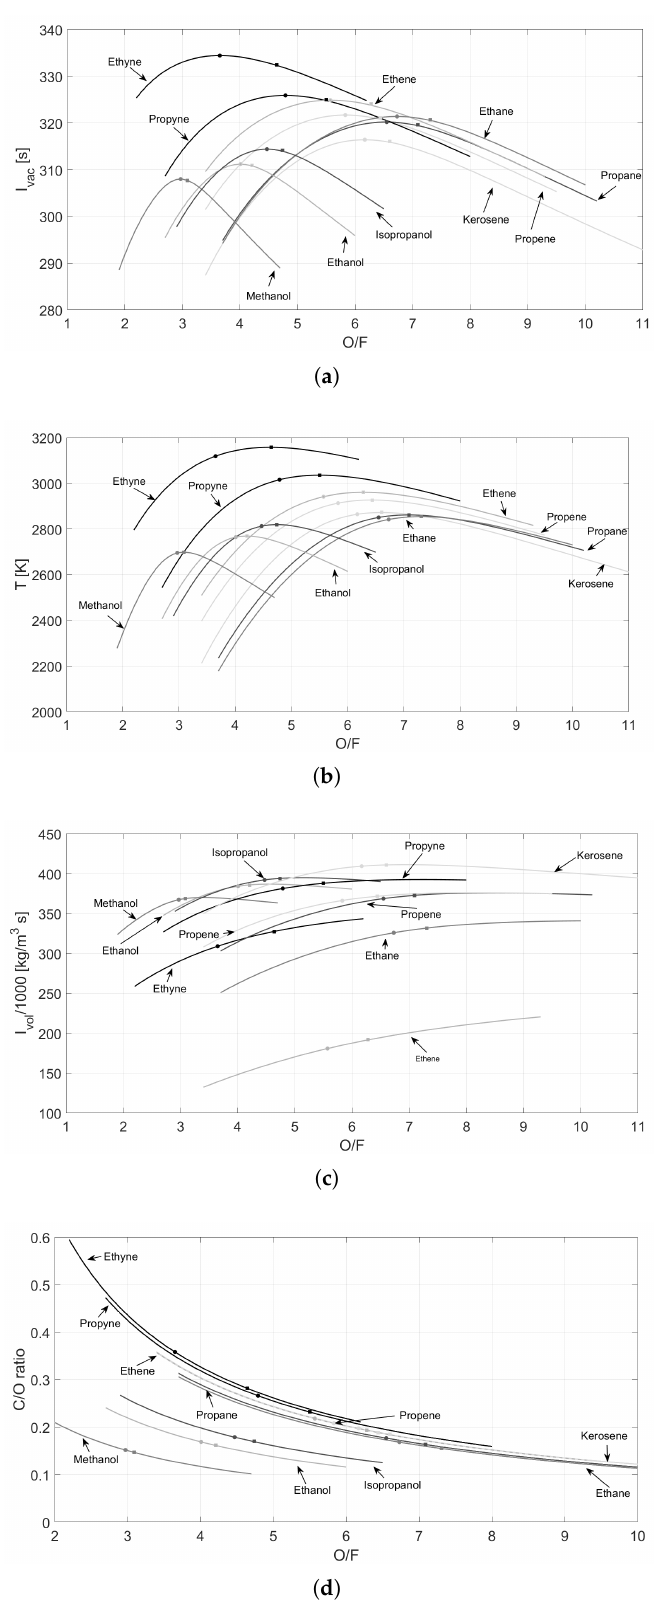
Figure 5. HTP 98%-based propellants performances: ( a ) vacuum specific impulse; ( b ) chamber temperature; ( c ) density impulse; and ( d ) C/O